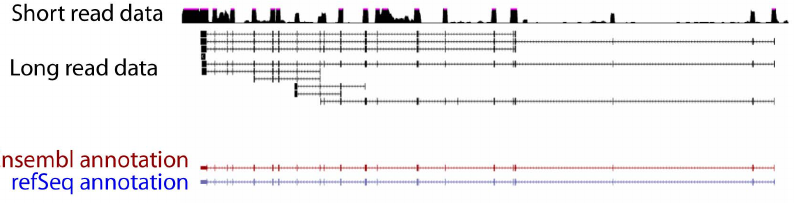
Figure 1. Long-read sequences map accurately to the chicken genome. Shown in this UCSC genome browser image is one example of a long-read alignment shown alongside the corresponding short-read data for this region as well as existing RefSeq and Ensembl annotations.